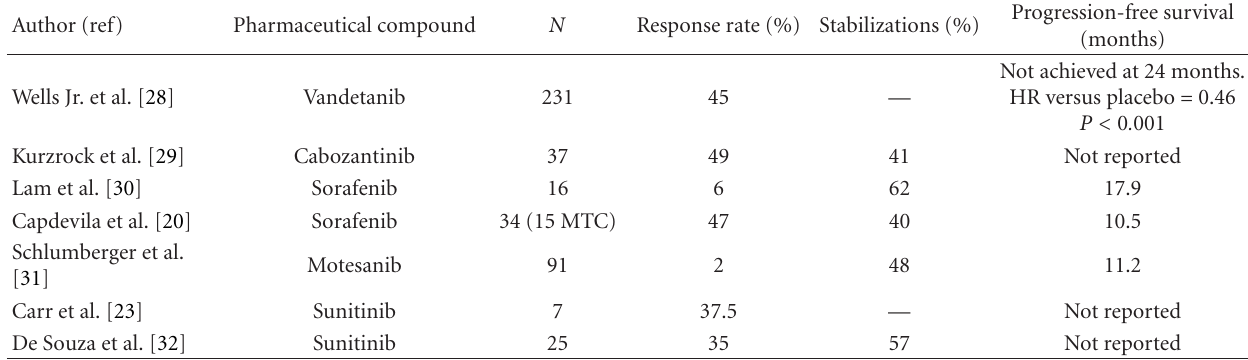
Table 3: Clinical data from studies with the main multi-target agents in clinical development for the treatment of medullary thyroid cancer. Author